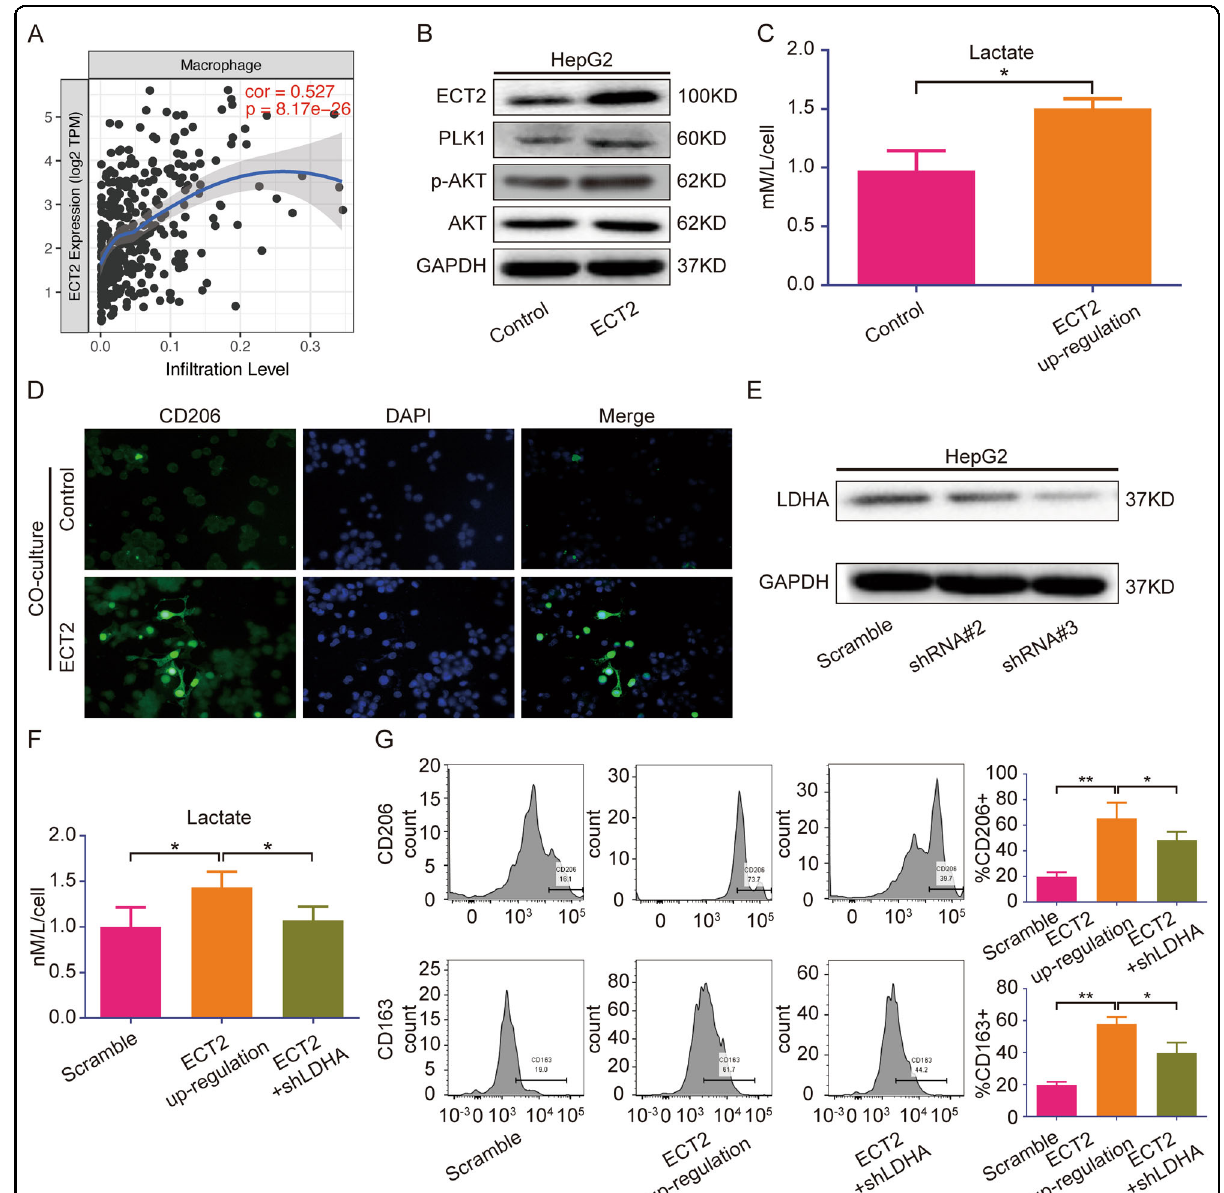
Fig. 6 ECT2 overexpression increases the production of lactic acid and subsequently promotes M2 macrophage polarization. A Correlation analysis between ECT2 and macrophages. B Western blot analysis of p-AKT, PLK1, and AKT expression levels after ECT2 was overexpressed in the HepG2 cell line. C Lactate acid production by cancer cells was evaluated after ECT2 was overexpressed. D Immuno fl uorescence analysis of macrophage polarization markers. E Western blot analysis was used to evaluate the effect of LDHA knockdown. F Lactate acid production by cancer cells was evaluated after ECT2 was overexpressed and/or LDHA was knocked down. G CD206 and CD163, which are polarization markers, were evaluated by fl ow cytometry after macrophages were co-cultured with cancer cells whose LDHA and/or ECT2 expression was in fl uenced. Error bars represent means ± SD. * p < 0.05, ** p < 0.01. NS means “ not signi fi cant ” by paired two-sided Student ’ s t